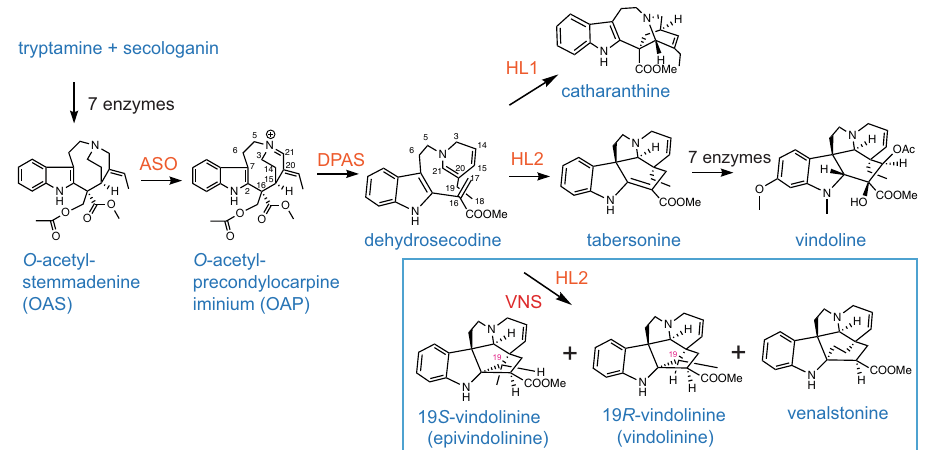
Fig. 1 The biosynthetic pathways from O -acetylstemmadenine for the three most abundant MIAs in Catharanthus roseus leaves: catharanthine, vindoline, and vindolinine epimers (19 R -vindolinine, 19 S -vindolinine) as well as venalstonine. ASO: O -acetylstemmadenine oxidase, DPAS: dihydroprecondylocarpine acetate synthase, HL1: hydrolase 1, HL2: hydrolase 2, VNS: vindolinine synthase. HL1 and HL2 have also been named catharanthine synthase and tabersonine synthase,